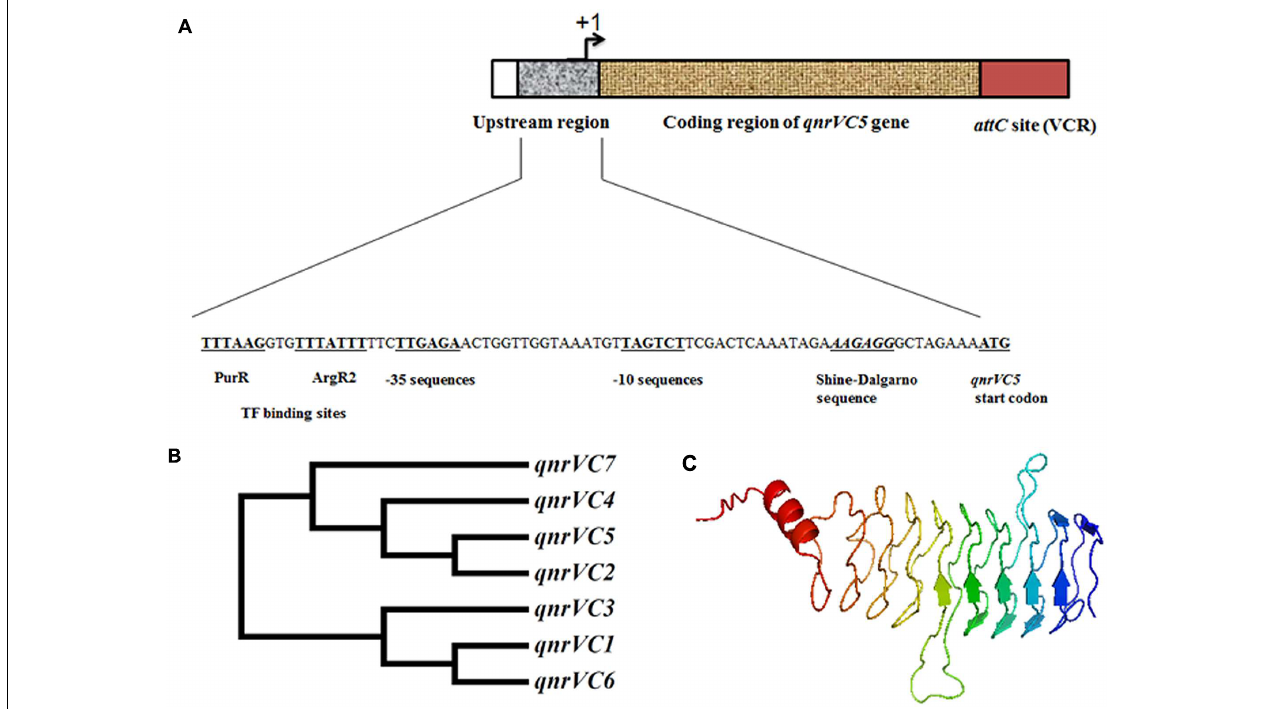
FIGURE 1 | The genetic environment, homology and structure prediction of the gene/gene product of qnrVC5 gene from V. fluvialis isolate BD146. (A) The structure of qnrVC5 gene cassette in pBD146 with canonical promoter sequence and VCR recombination site, at the upstream and downstream positions of the coding region, respectively. (B) Dendrogram of qnrVC5 allele with other qnrVC alleles, showing the close relationship of qnrVC5 with qnrVC2 and qnrVC4. (C) Structure prediction of QnrVC5 using I-TASSER server, showing right handed quadrilateral β -helix forming 10 coils, interrupted by two